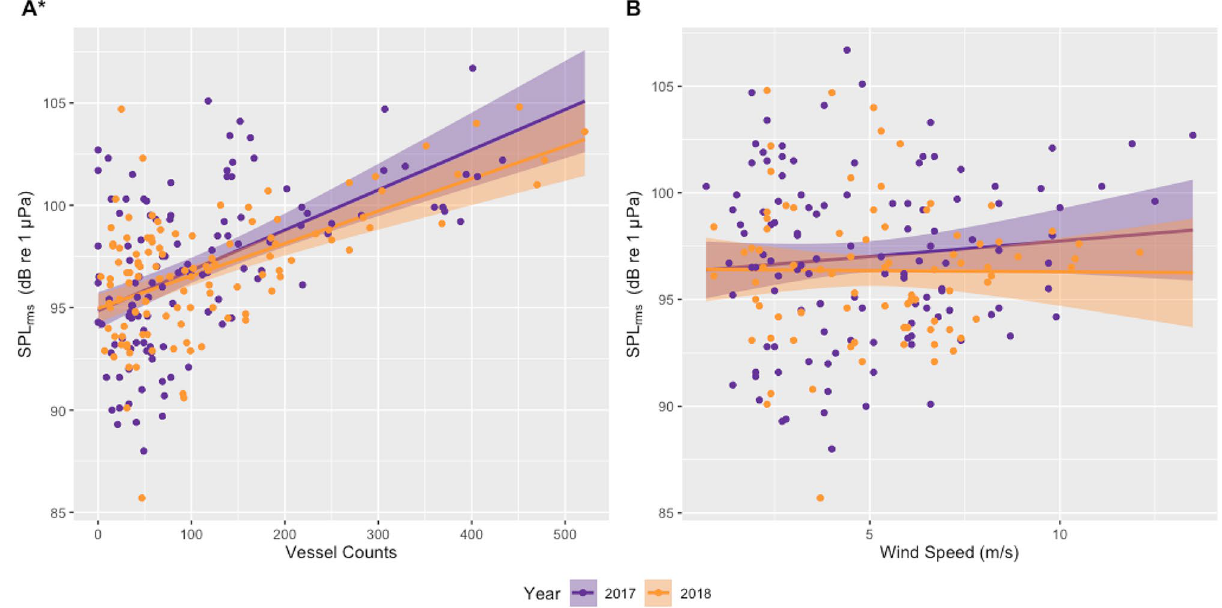
Figure 2. Linear correlations between noise levels (daily median root mean square [rms] sound pressure level [SPL] in dB [re 1 μPa]; 50–1000 Hz) recorded on a hydrophone deployed outside the Newport harbor entrance USA (station NWPO3). Asterisk indicates significant correlations between SPL and vessel counts in both